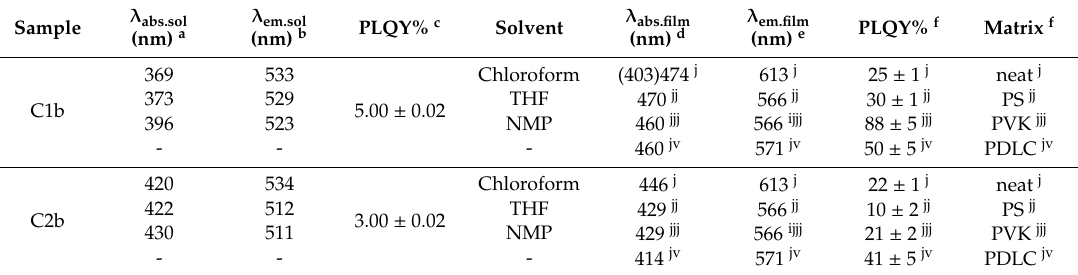
Table 1. Optical data of C1b and C2b in solution and as neat and dispersed